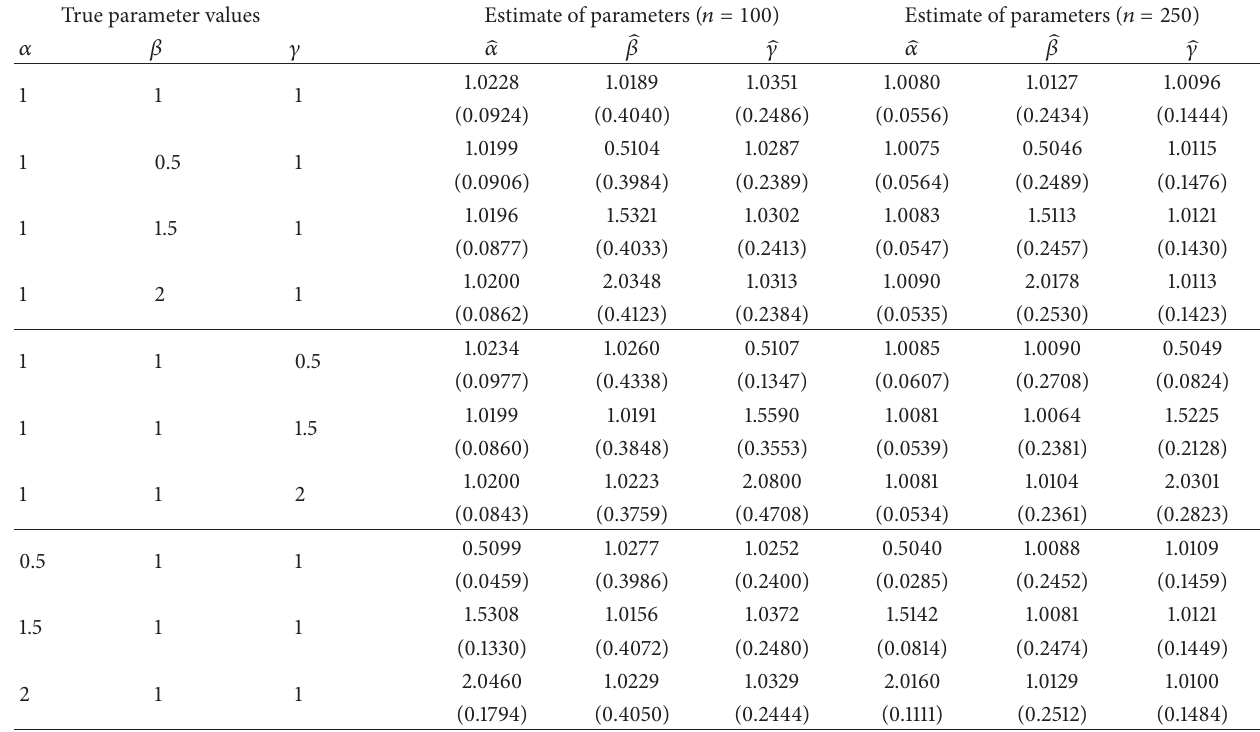
Table 1: Averages and standard deviation (in brackets) of parameter estimates.